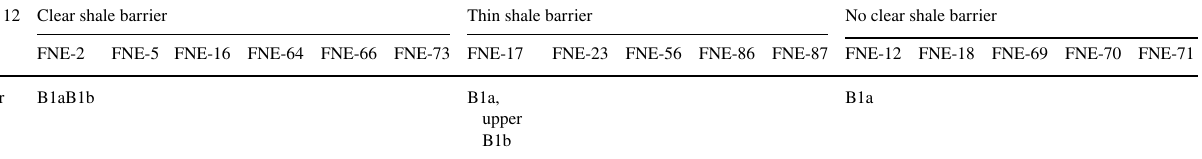
Fig. 14 Sand section around FNE-86 and FNE-87 Table 15 Perforation of each well in Case 12 Case 12 Clear shale barrier Thin shale